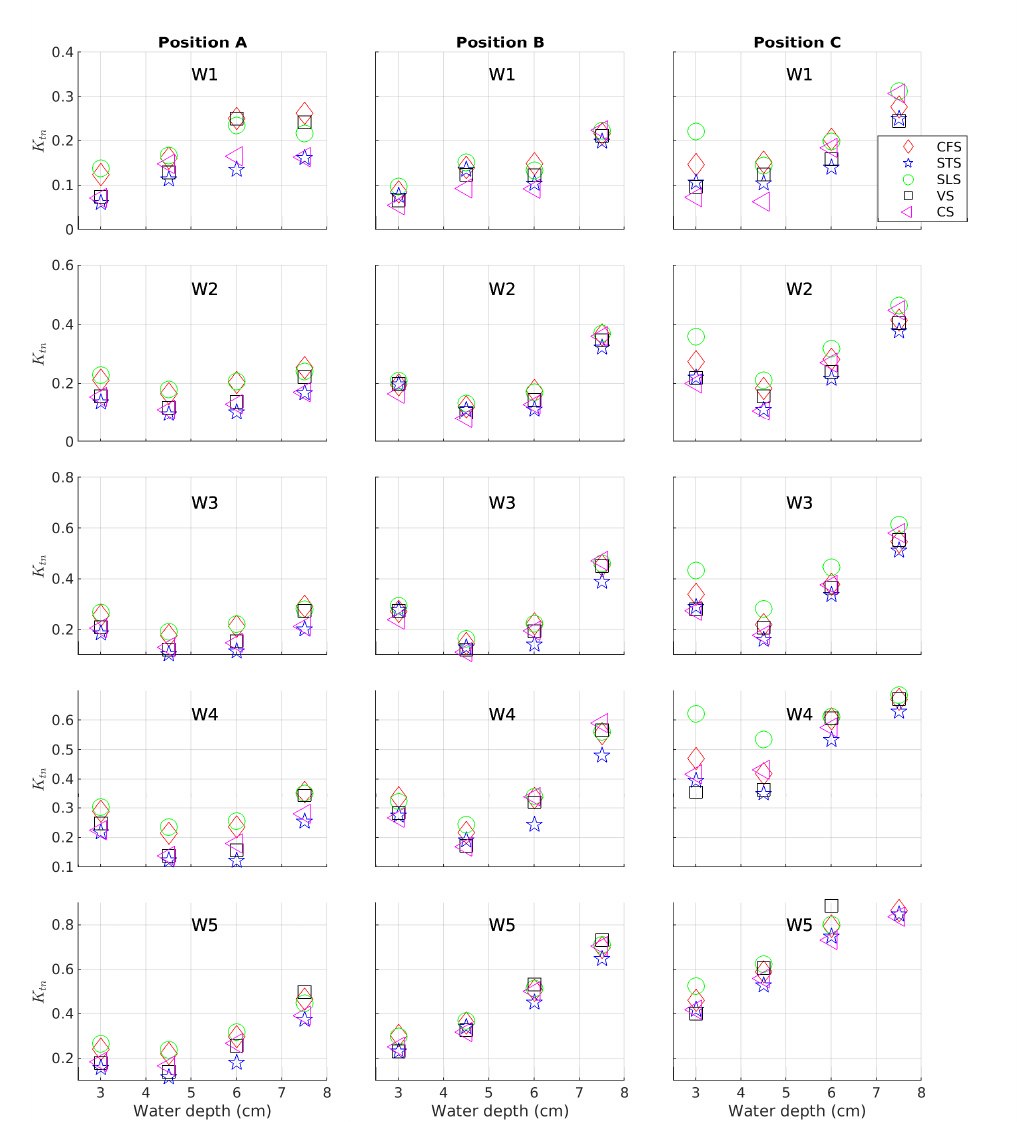
Figure 5. Normalized SW transmission coefficient vs. reef flat water depth. Water depth, wave condition, seawall position, and seawall shape are depicted in x -axis, rows, columns, and colored markers, respectively. Note the difference in y -axis